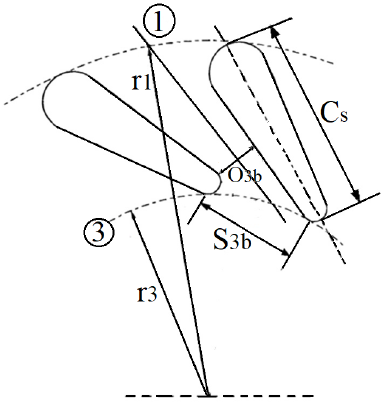
Figure 5. Simplified diagram of the nozzle adapted from [29].